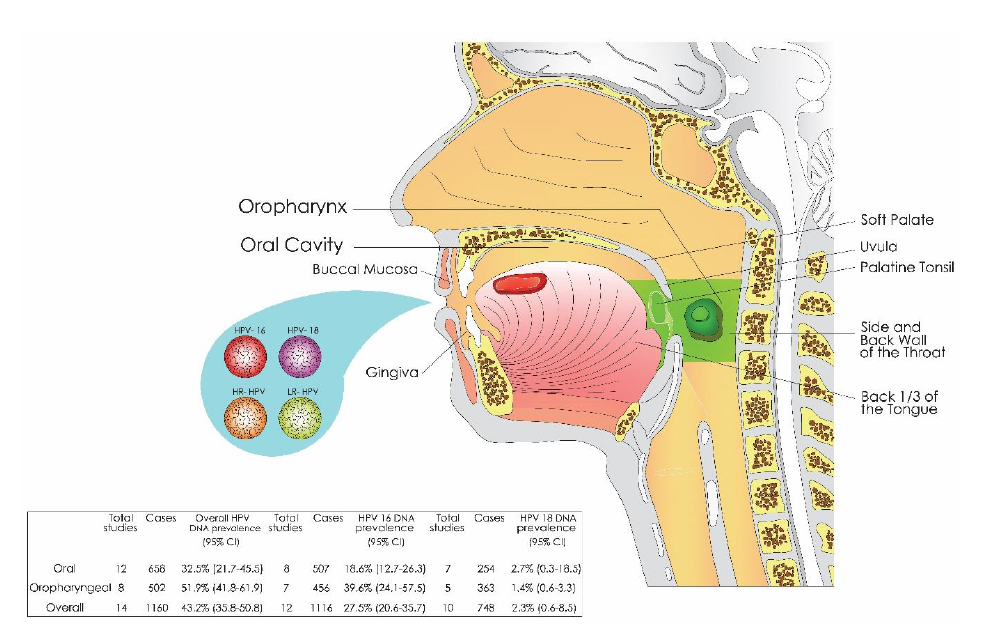
Figure 2. Schematic drawing of salivary HPV and prevalence of oral and / or oropharyngeal cancer. Oral tissue sheds pathogen-infected cells containing different HPV DNA genotypes (HPV16, HPV18, HR-HPV, and LR-HPV) into saliva (with or without oral rinses). The prevalence of salivary HPV DNA varied according to anatomic tumor location, showing the highest infection rate in oropharyngeal carcinomas. In addition, the type-specific prevalence in saliva was also different according to the anatomic tumor location.